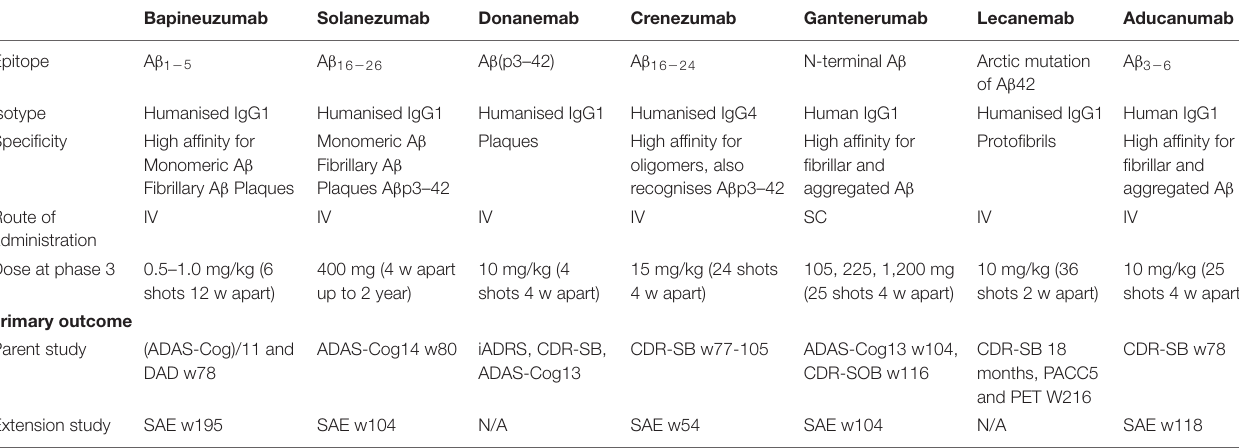
TABLE 2 | Characteristics of passive immunotherapy for Alzheimer’s disease in phase 3.